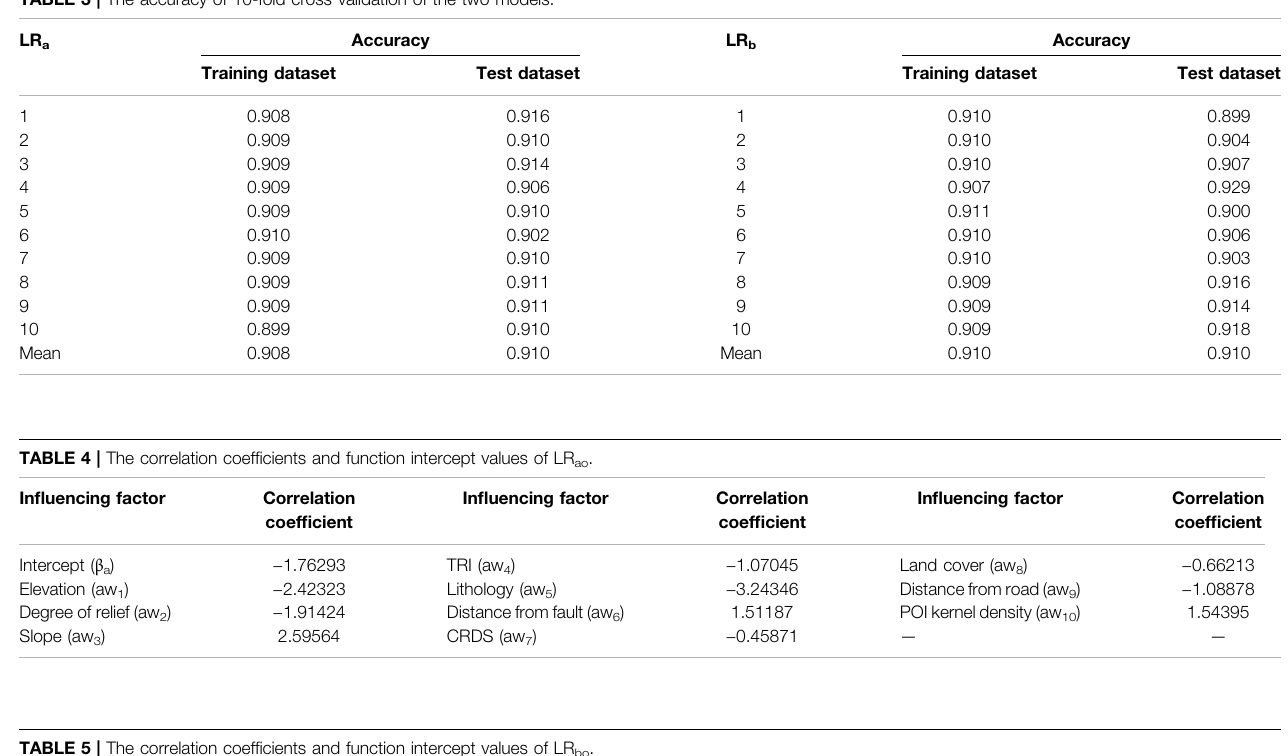
TABLE 3 | The accuracy of 10-fold cross validation of the two